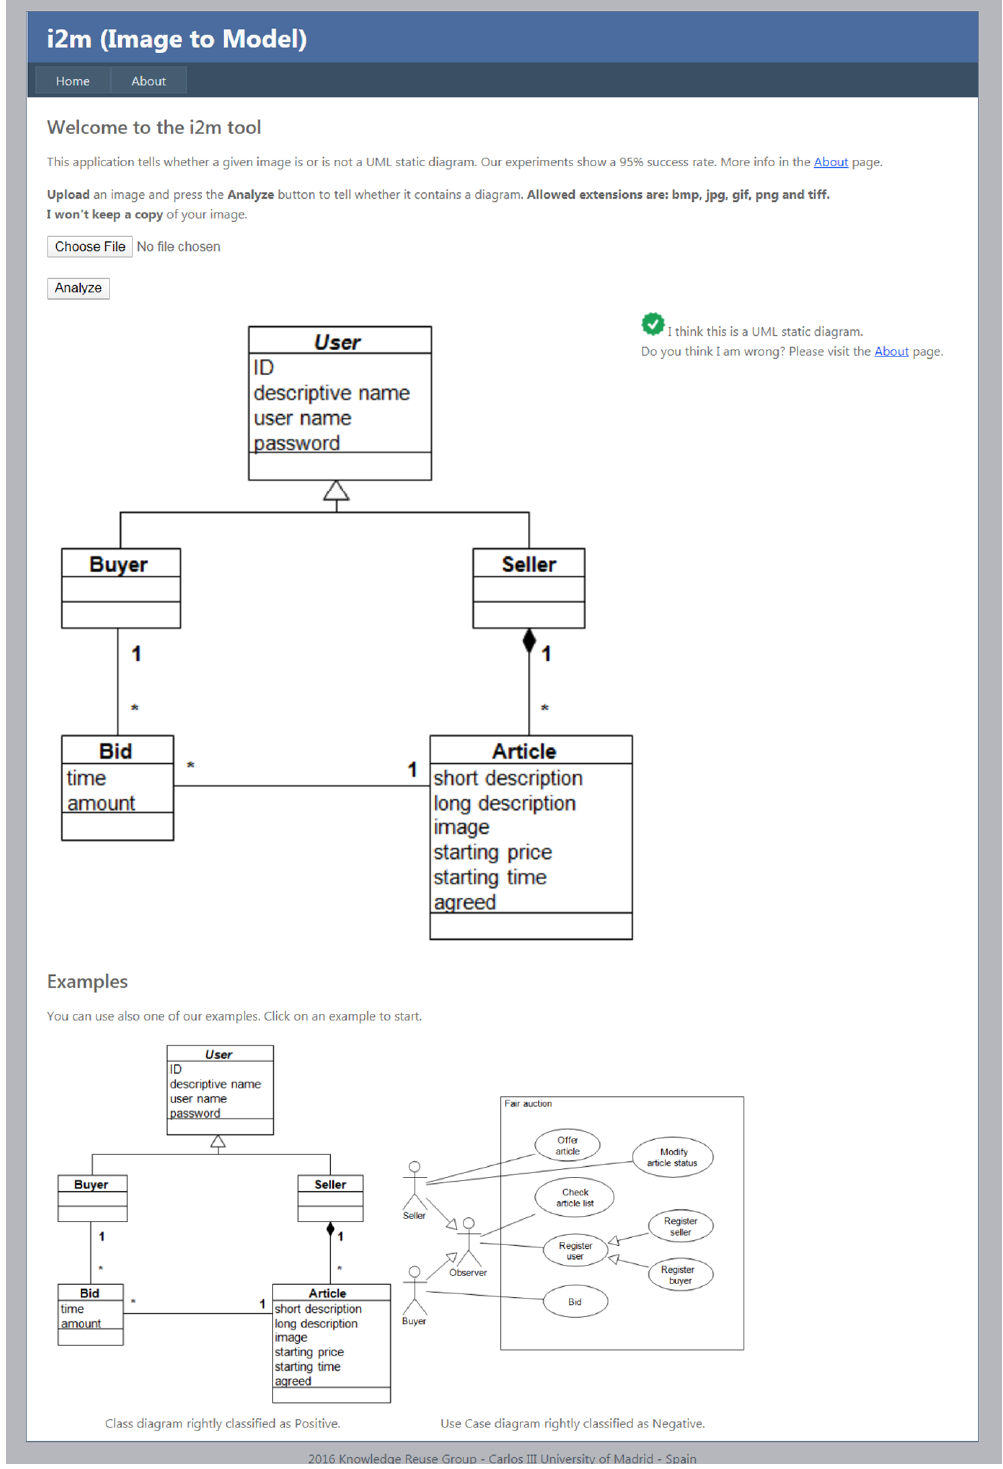
Figure 14. The i2m (image-to-model)